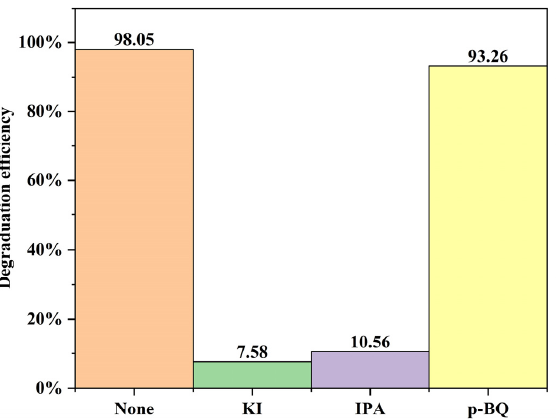
Figure 13. Degradation rate constants of different free radical trapping agents on OZN-10.